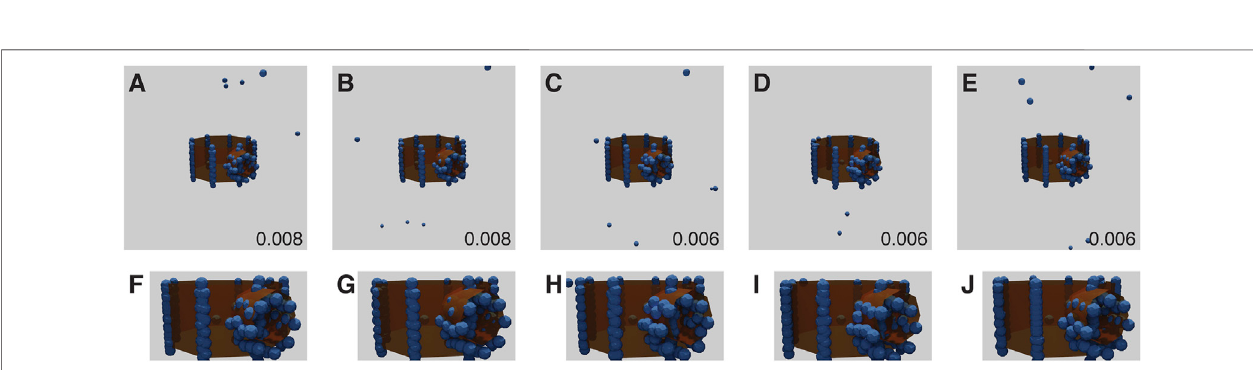
FIGURE 6 | Baseline CEP152/HsSAS-6 approximation experiment results for each run ( (A – E) , top row ) with RMSD score. The ground truth model is shown in orange, with the inferred structure shown as blue spheres, overlaid and aligned. Bottom row (F – J) : close up of the top row. Note the slight offset of the smaller, reconstructed cylinder from the ground-truth. The parameters for this experiment can be found in Supplementary Table S5.3